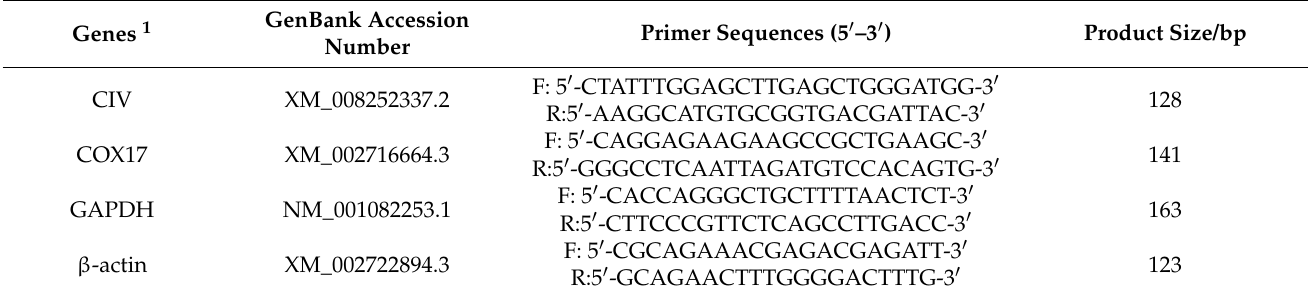
Table 3. Primer sequences of related